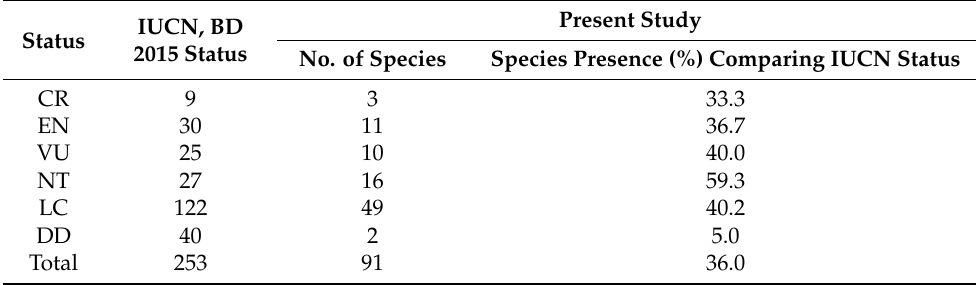
Table 2. National conservation status of fish